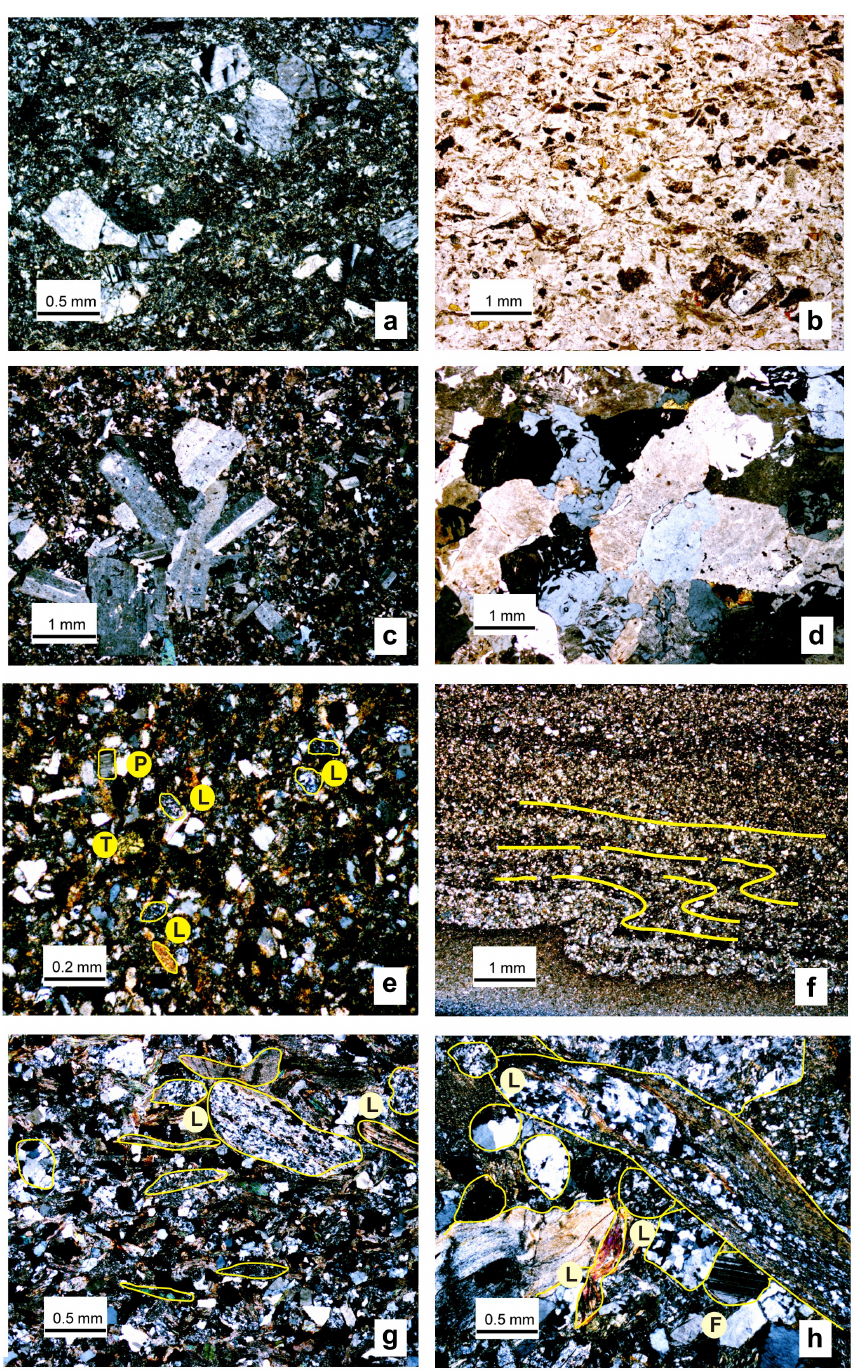
Figure 5. Petrographic images of the Carboniferous sedimentary and igneous rocks of the Santa Susana–São Cristovão region: (a) rhyolitic– rhyodacite tuff of the Toca da Moura volcano-sedimentary complex showing quartz and feldspar phenocrysts enclosed in an ash matrix; (b) rhyolitic tuff showing flattened dark-brown millimeter-sized pumice and lithoclasts enclosed in an ash matrix; (c) porphyritic texture of the Baleizão rhyodacite–rhyolite characterized by quartz, plagioclase, K-feldspar, biotite, and amphibole phenocryst embedded in a fine- grained silicic matrix; (d) cobble of fine-grained granite showing graphic intergrowths of quartz and alkali feldspar, found in conglomerate from the Santa Susana Formation; (e) siltstone of the Toca da Moura volcano-sedimentary complex mostly composed of quartz grains and a few grains of plagioclase (P), tourmaline (T), and rock fragments (L); (f) siltstone of the Cabrela volcano-sedimentary complex showing fining upward grading and a slump fold; and (g, h) sandstones from the Santa Susana Formation with a high percentage of lithoclasts (L) and feldspar